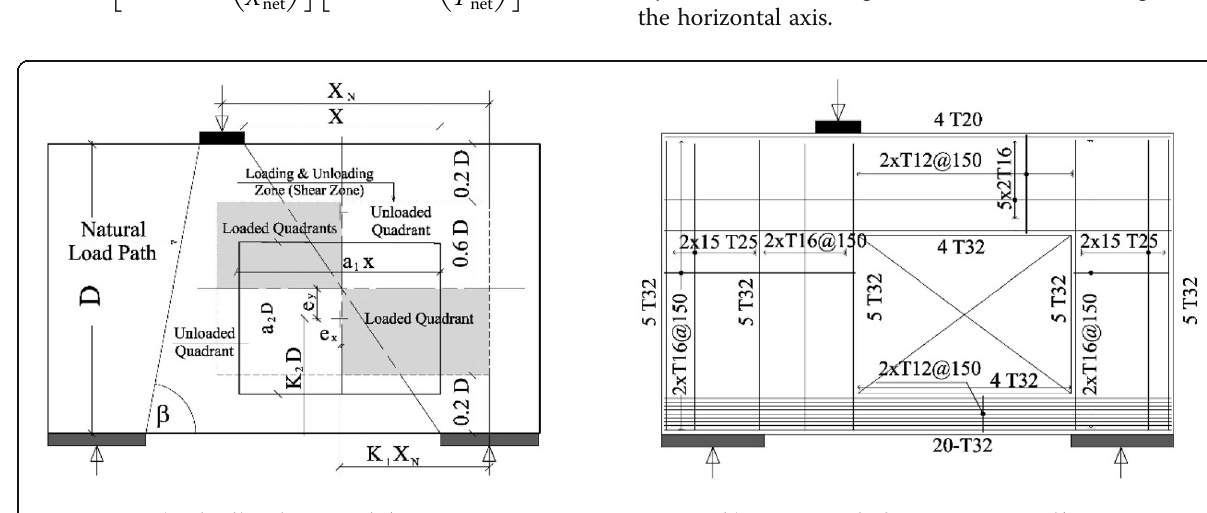
Fig. 2 Kong. F.K [15] model. a Idealization model. b Beam reinforcement